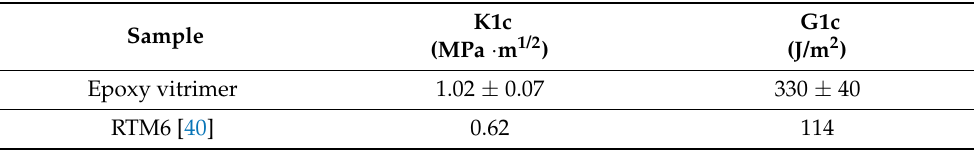
Table 3. Fracture toughness test results.